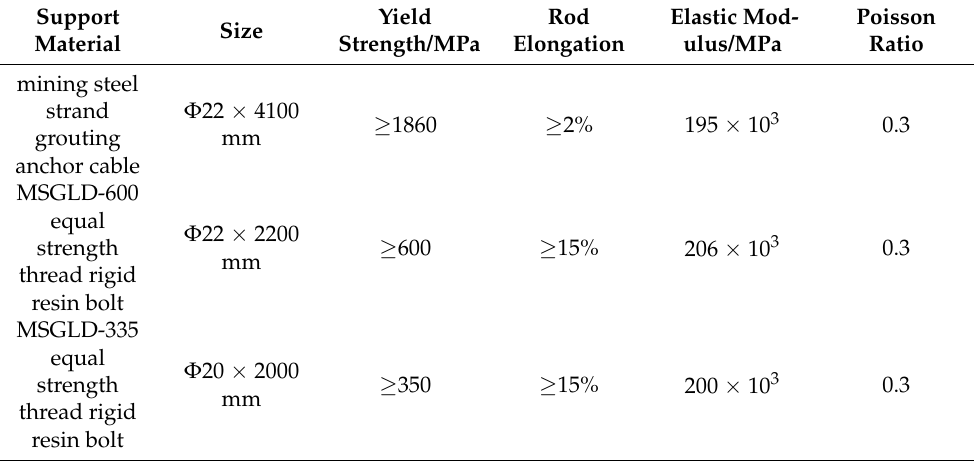
Table 2. Properties of supporting materials